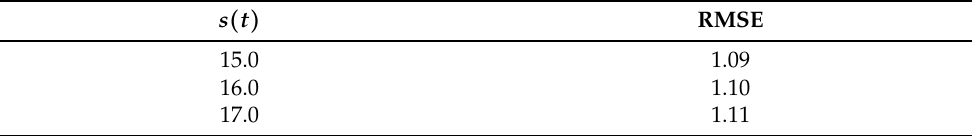
Table 1. RMSE for three types of s ( t ) .